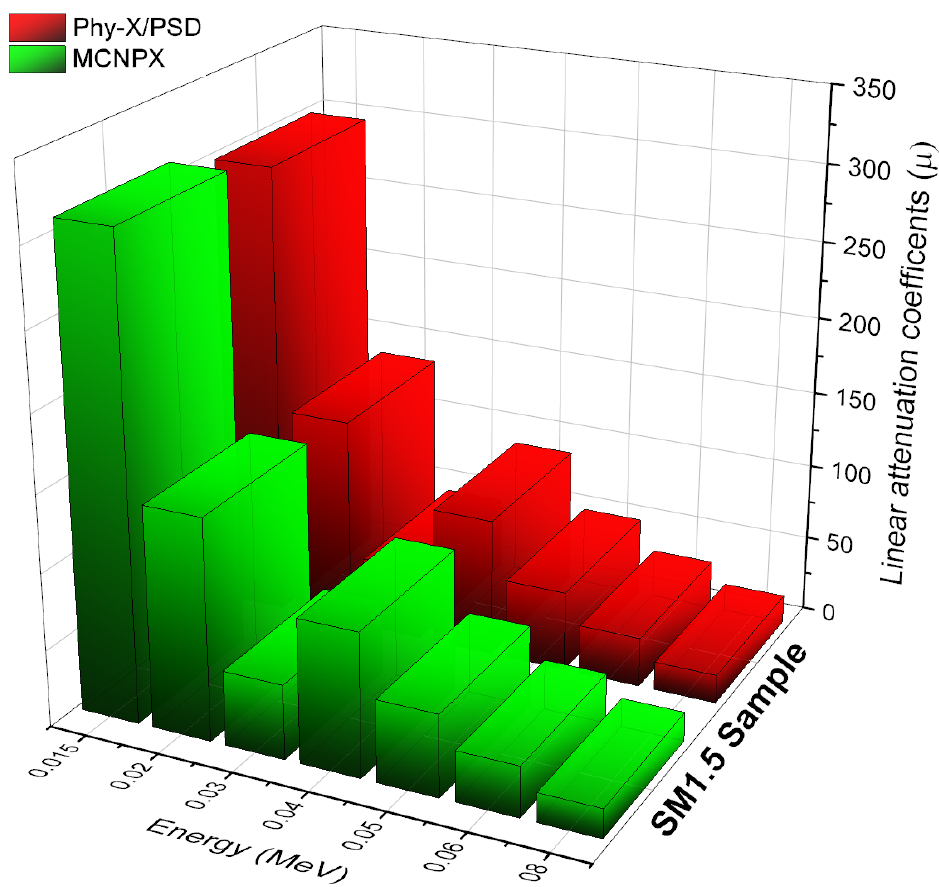
Figure 2. Comparison of linear attenuation coefficient (µ) values for SM1.5 sample obtained from MCNPX and Phy-X/PSD at low gamma ray energy region.